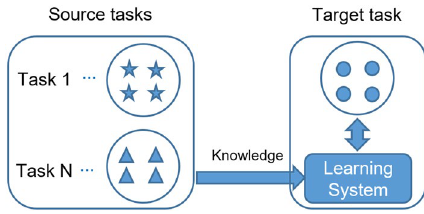
Fig. 3 Transfer learning process Fig. 4 Overview of the transfer optimization learning